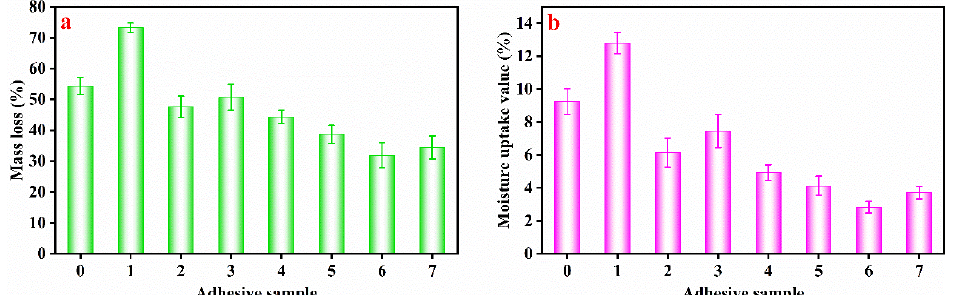
Figure 5. The (a) mass loss and (b) moisture uptake value of the different adhesive samples: (0) HPM adhesive, (1) HPM-papain adhesive, (2) HPM-sodium dodecyl sulfate (SDS) adhesive, (3) HPM-urea adhesive, (4) HPM-PAE adhesive, (5) HPM-papain-PAE adhesive, (6) HPM-SDS-PAE adhesive, (7) HPM-urea-PAE adhesive.